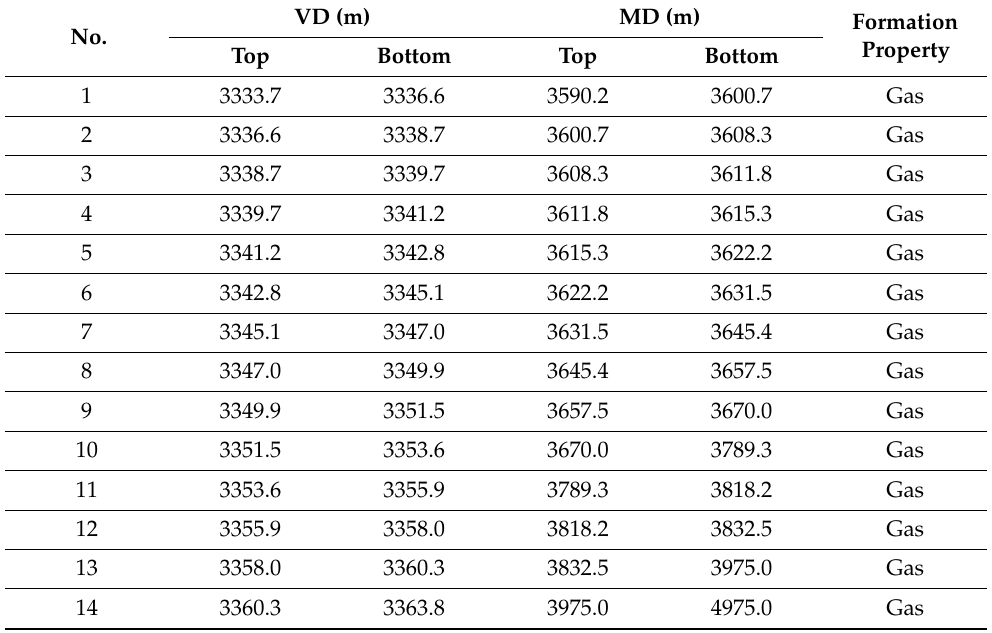
Table 1. Geological stratification